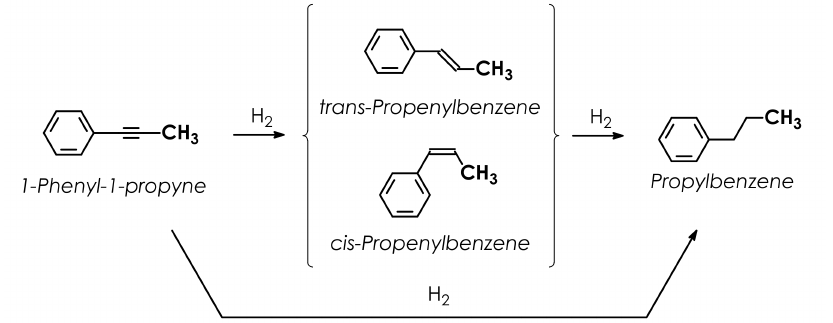
Figure 9. The reaction network in hydrogenation of